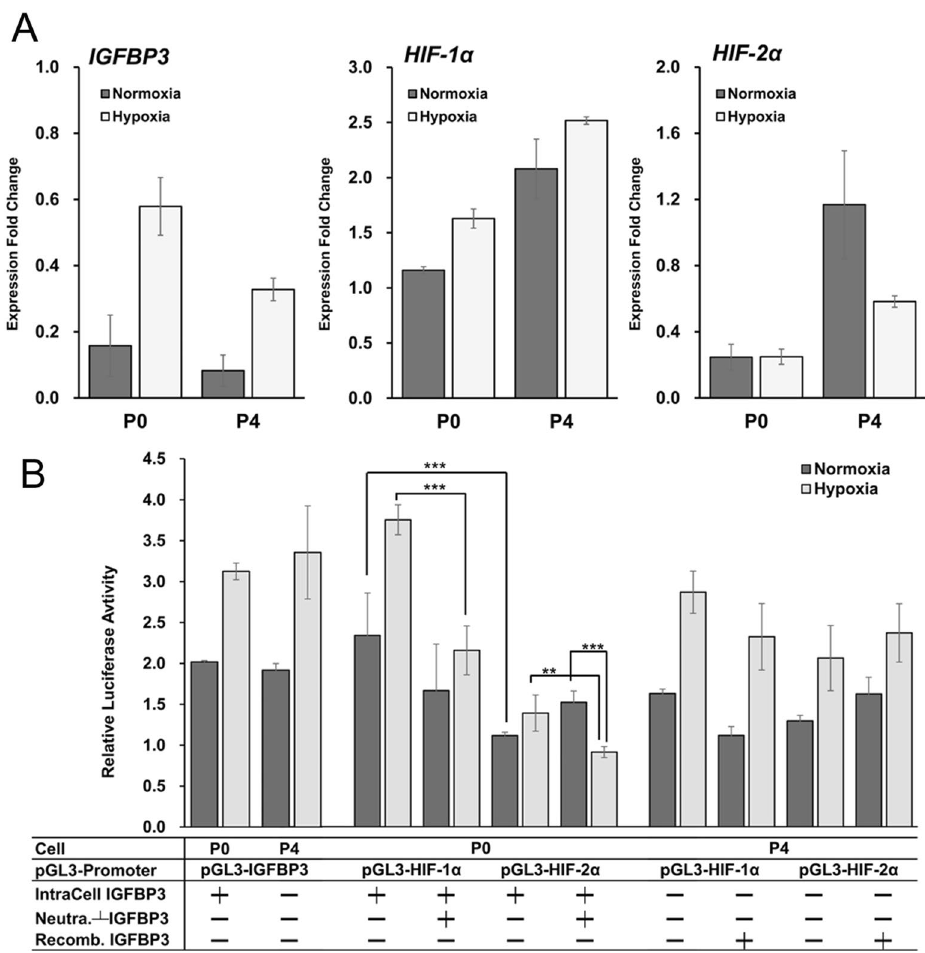
Figure 5. IGFBP3 differentially regulated HIF-1α and HIF-2α synthesis in low and high invasion ability cells. Gene expression and regulation of IGFBP3, HIF-1α, and HIF-2α in cells cultured under normoxic and hypoxic conditions. ( A ) qPCR analyzed of IGFBP3, HIF-1α, and HIF-2α mRNA expressions in P0 and P4 cultured under normoxic and hypoxic conditions. GAPDH as the normalized control. P4 expressed higher HIF-1α and HIF-2α under normoxia, and P0 expressed lower HIF-2α compare with P4. ( B ) Luciferase promoter assays on the regulations of IGFBP3, HIF-1α, and HIF-2α promoters in P0 and P4 under normoxic and hypoxic conditions. The table below indicates the presence of endogenous or exogenous IGFBP3. In high-IGFBP3 expression P0, HIF-1α was more activated than HIF-2α at hypoxia. Both HIF-1α and HIF-2α were reduced after depletion of extracellular IGFBP3 by neutralizing antibodies (lanes 4 and 6). In low-IGFBP3 expression P4, both HIF-1α and HIF-2α activities increased under hypoxia. There were no changes in HIF-1α and HIF-2α expressions after adding recombinant hIGFBP3 (lanes 8 and 10). Each sample was assayed and analyzed repeated three times independently. (The error bars represent the SDs; ** P < 0.001, *** P < 0.0005.). Excel 2016 was used to generate charts. Photoshop CS2 version 9 was used to assemble the